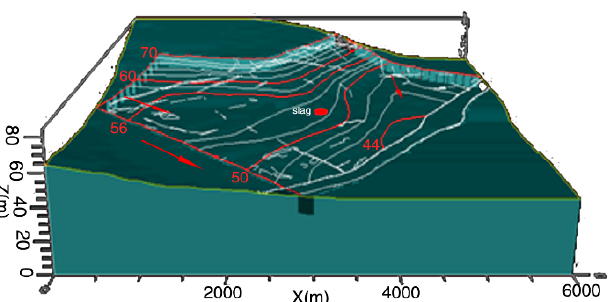
Figure 3. Terrain, boundary, and surveyed groundwater head distribution of the study area.